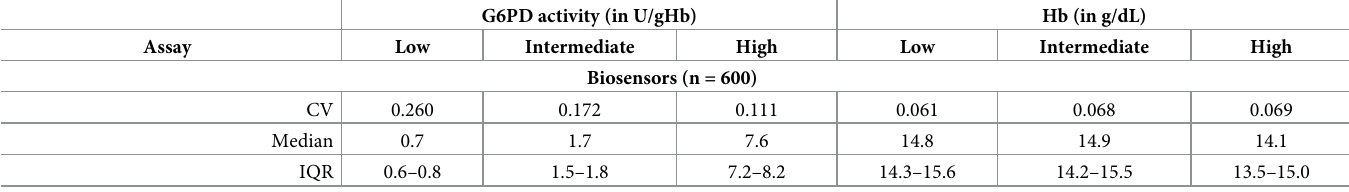
Table 2. Phase A results: coefficient of variation and median value measured for all Biosensors combined, spectrophotometry and Hemocue. Summaries are for all Phase A results